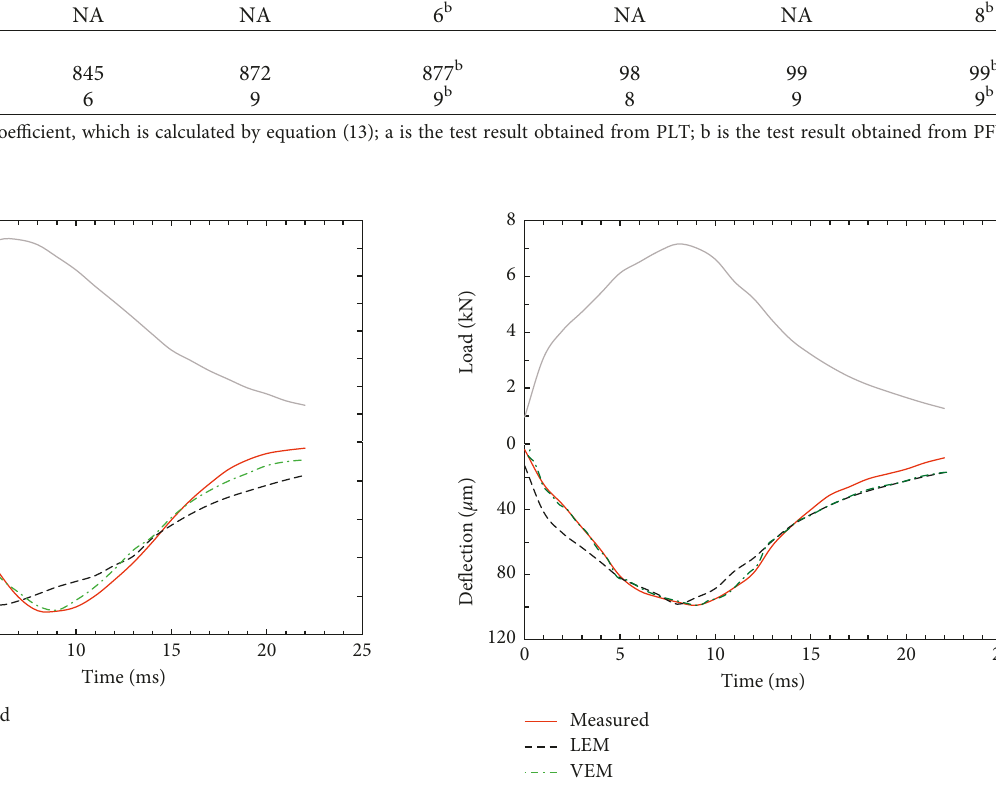
Figure 10: Comparison of measured and back-calculated de- flection-time curves of U4.